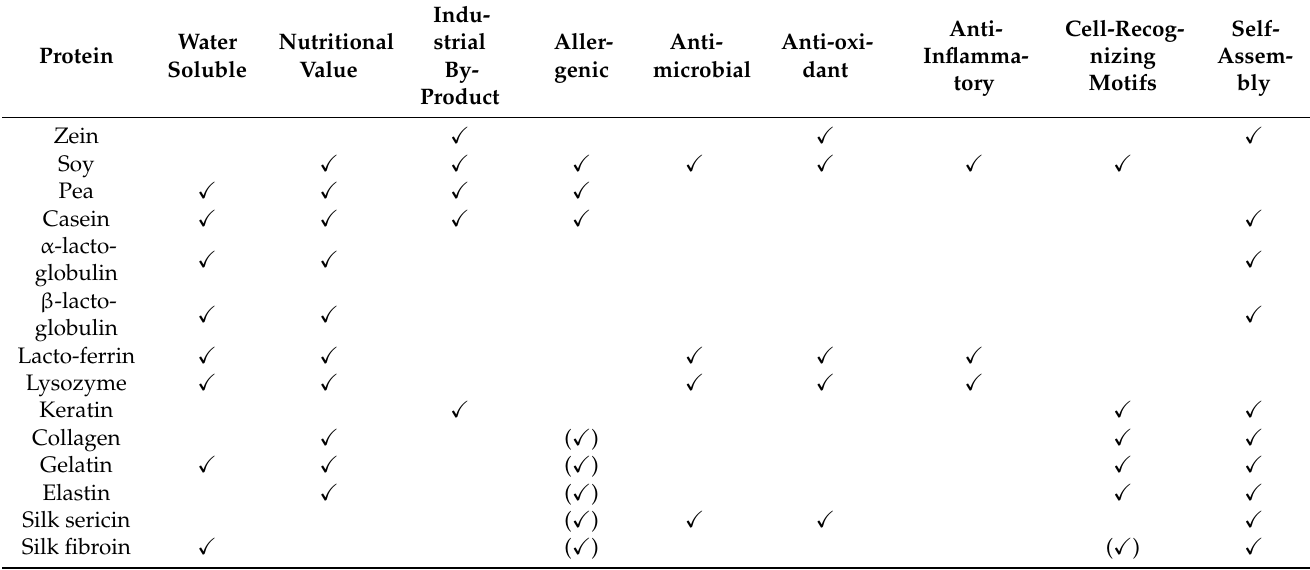
Table 4. Biological properties and other relevant features of plant- and animal-derived proteins.